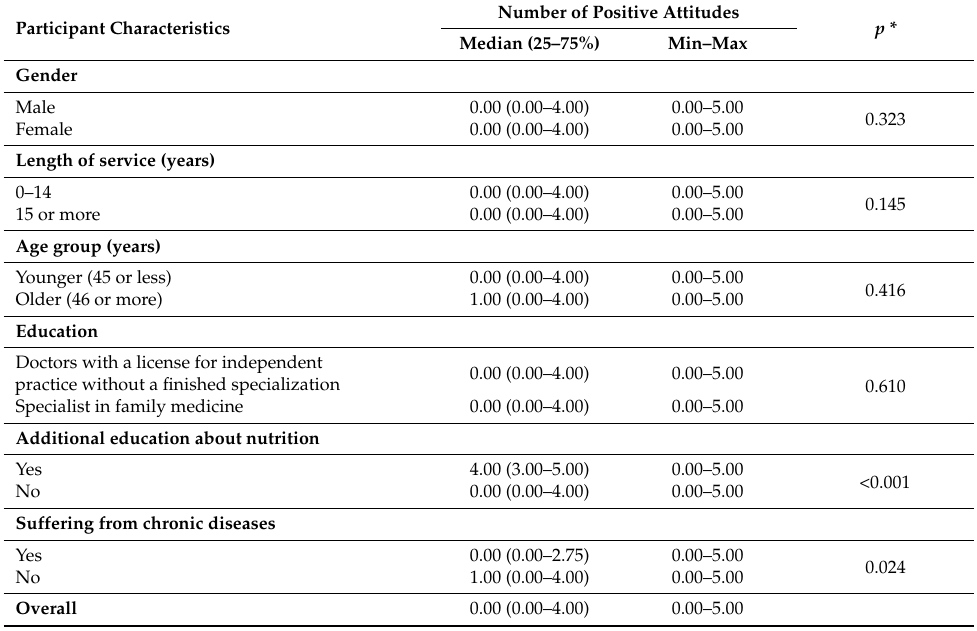
Table 3. Attitudes of Croatian GPs toward the nutrition care according to the sociodemographic characteristics of study